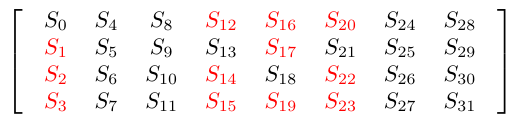
Figure 12: The 12 active nibbles after MatrixMul in the first round, marked in